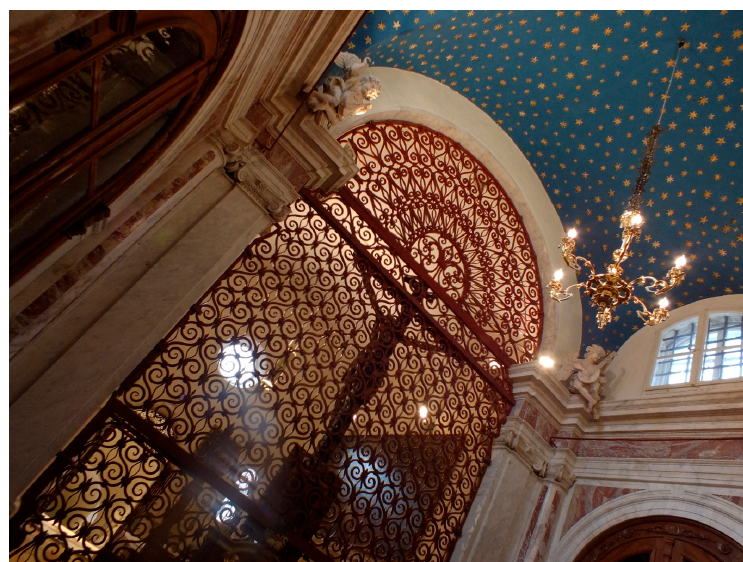
Figure 4. Grid, 17th century, Saint Tryphon’s relic chapel, Kotor, photo by author.